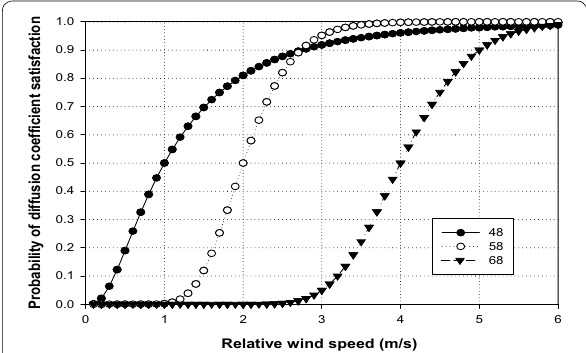
Fig. 7 Satisfaction Curve of wind speed parameter for combine chloride diffusion coefficient rate (48, 58, 68).